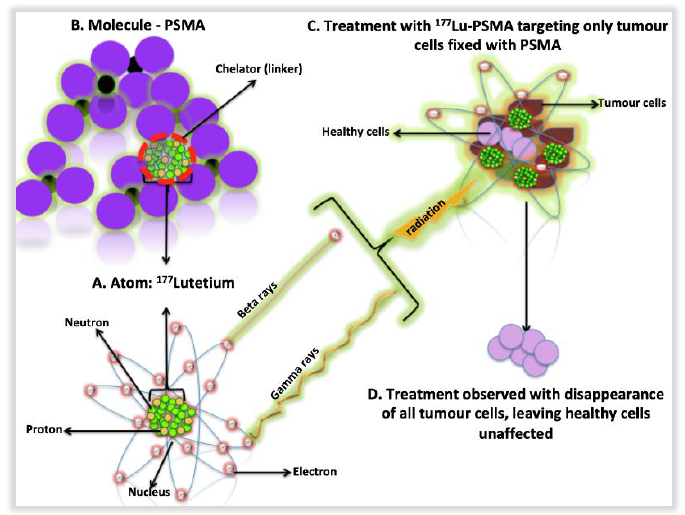
Figure 4. Radionuclides-based therapy pathway and killing of tumour cells through targeted alpha therapy using 177 Lutetium-PSMA as an example. ( A ) The radionuclide (e.g., 177 Lu-PSMA) is the radioactive isotope that releases energetic particle radiation such as α or β particles for therapeutic purpose. ( B ) The second part is a small peptide that is designed to bind to the cellular target of interest. The third part is a linker molecule that serves to connect the radionuclide with the leading peptide. In PRLT of PCa, 177 Lutetium, a β particle-emitting radionuclide, is the most commonly radionuclide that is complexed to a PSMA ligand using a linker molecule. Following the intravenous administration of 177 Lu-PSMA, the complex easily permeates into tumor foci with the smallness of the complex facilitating efficient penetration into the tumour core. ( C ) Following binding to the extra-cellular component of the PSMA receptor expressed on the tumor cell membrane, 177 Lu-PSMA-receptor complex undergoes internalization into the tumor cell cytoplasm. ( D ) This allows radiation delivery to occur near the tumor nuclei making tumor cell killing more efficient. In addition to β particle emission, 177 Lutetium also emits γ photons (for diagnostic purpose) that can be used for imaging using a single photon emission tomography (SPECT) imaging technique. The ability to perform imaging following the administration of 177 Lu-PSMA for PRLT allows for the determination of the in vivo distribution of the therapy agent and the confirmation of the uptake of the treatment agent at the tumor sites. In addition, imaging the γ photons of 177 Lutetium allows for the determination of the radiation dose delivered to the tumor foci (dosimetry).